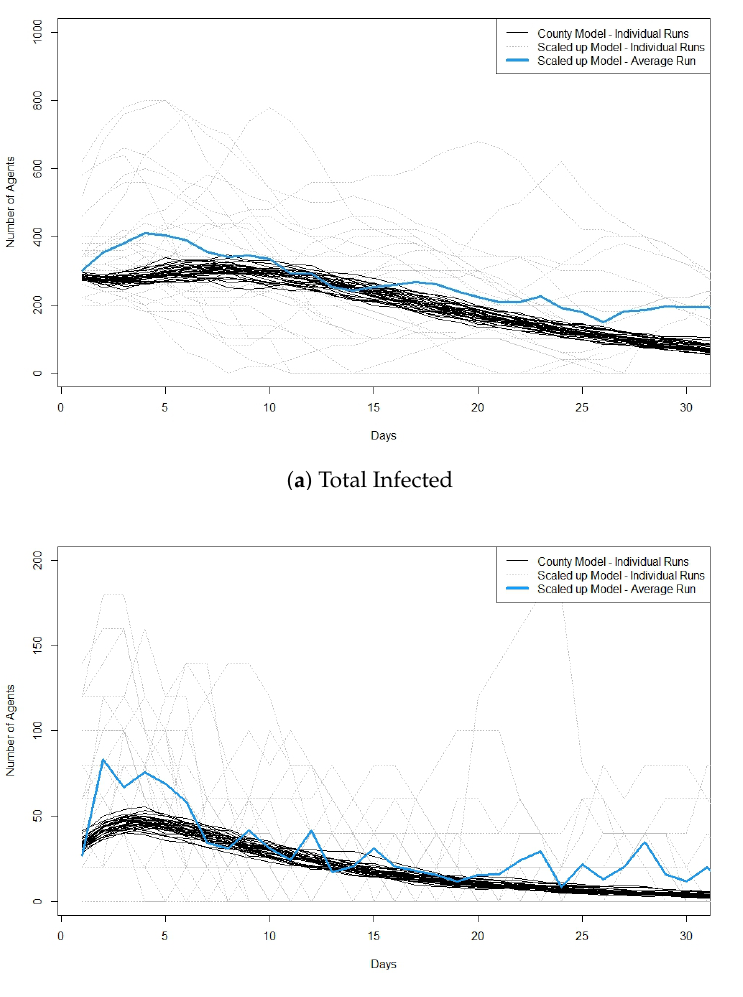
Figure 1. Plots showing cross validation results when 300 agents are infected at the start of the run in the original model and 3 agents are infected at the start of the run in the scaled model. ( a ) shows the total number of infected agents per day and ( b ) shows the newly infectious agents per day. For the scaled model the y -axis is the number of infected × 100. We also plot the average value across the 30 runs of the scaled model. Best viewed in